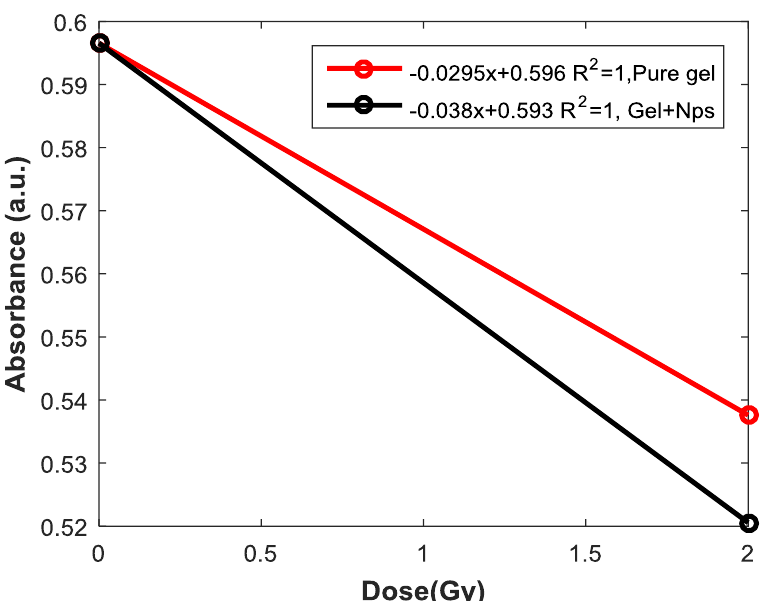
Fig. 7. Absorbance-dose curve containing the nanoparticles at 0.1 mM concentration compared to the pure gel